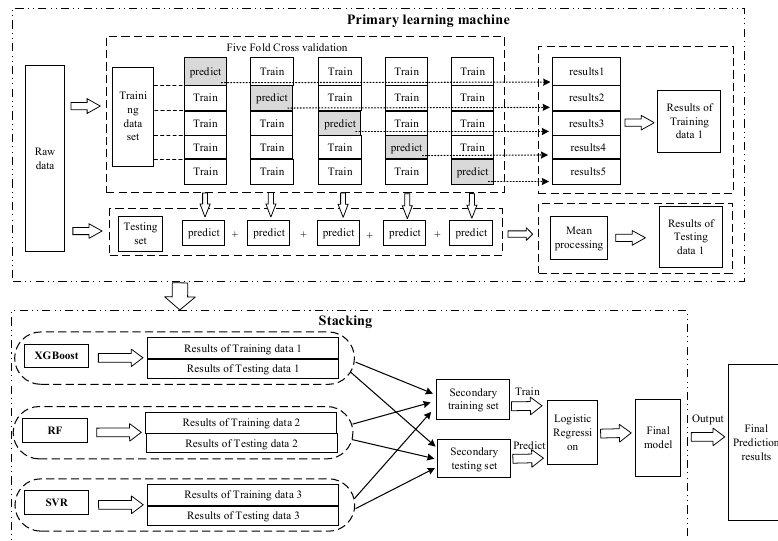
Figure 1. Diagram of the proposed highway blocking loss prediction